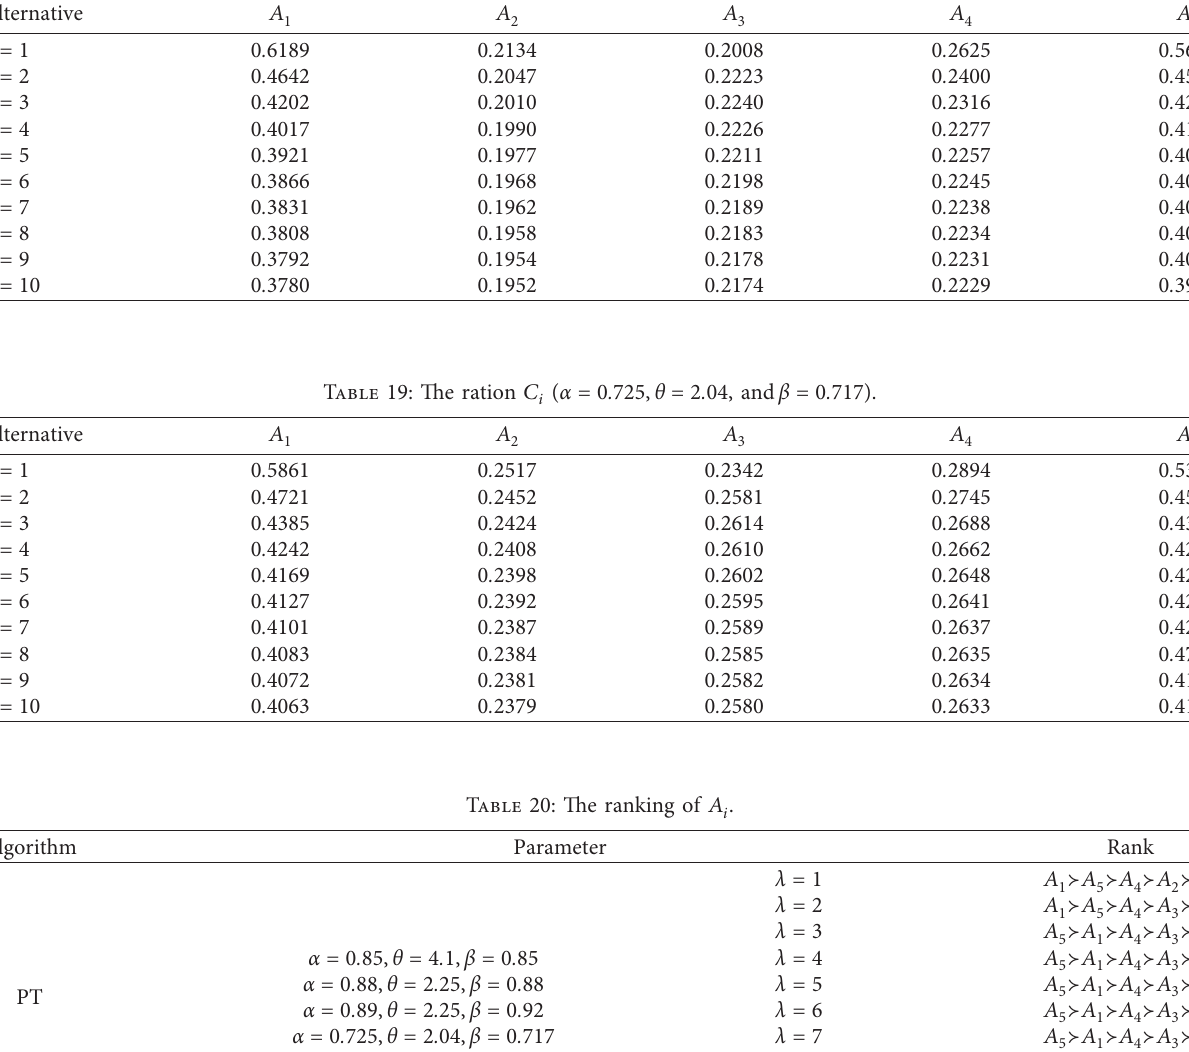
� 0 . 89 , θ � 2 . 25 , and β � 0 . 92). i based on PT ( α